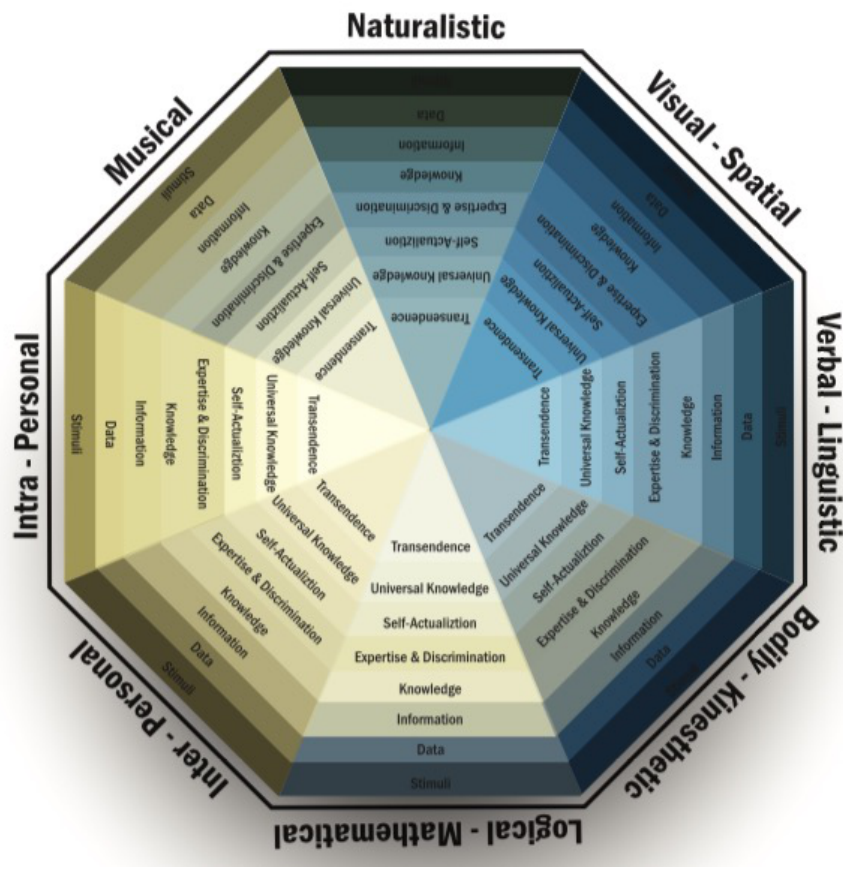
Fig. 4. The Consciousness-Intelligence-Knowledge Pyramid